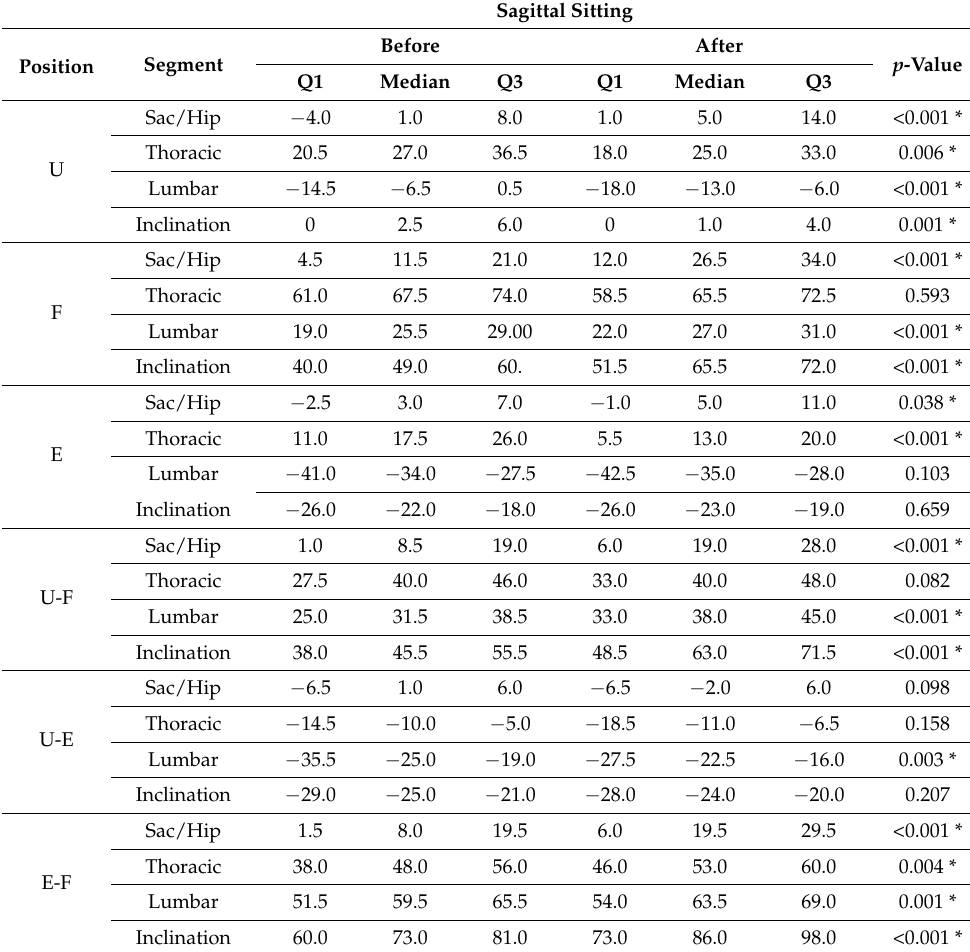
Table 6. Medians and interquartile ranges of total inclination and lumbar, thoracic and sacrum/hip inclinations in degrees measured before and after the intervention in sitting position in the sagittal plane: upright (U), flexion (F), extension (E), and estimated ROM from upright to flexion (U–F), upright to extension (U–E) and extension to flexion (E–F) ( n = 76). Sagittal Sitting Before Position Segment